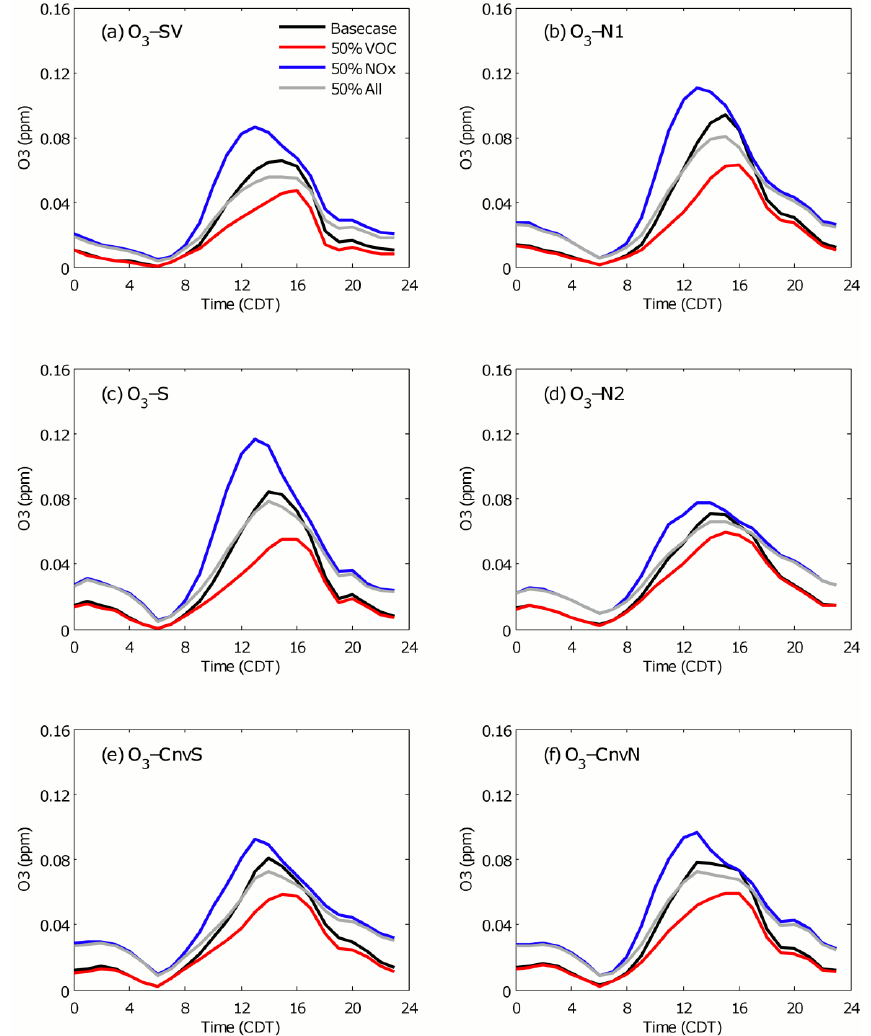
Fig. 10. Time series showing the sensitivity of ozone production to ozone precursors under different meteorological conditions, compared to the base case. Data were averaged over 15 RAMA monitoring stations and over each period. Black line indicates the base case, red indicates the ozone concentrations with 50% reductions in VOC emissions, blue indicates those with 50% reductions in NO x emissions, and gray indicates those with 50% reductions in both VOC and NO x emissions.